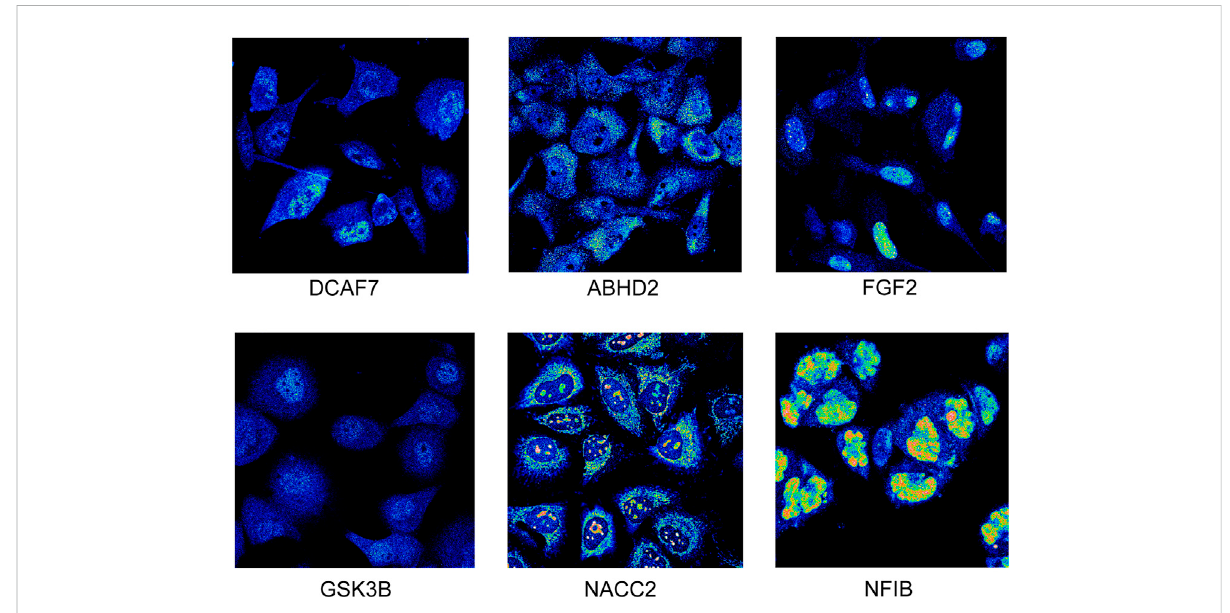
FIGURE 7 Immuno fl uorescence staining. The expressionof prostate cancer hub genesin differentcellular locations. (image extracted from https://www.